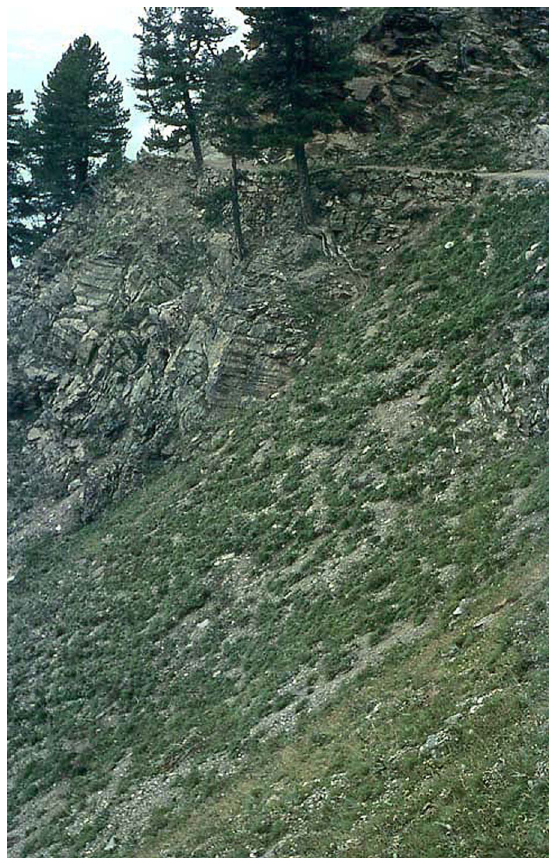
Fig. 14: Trampling effects in a sheltered site within the subalpine forest ( Larix decidua , Pinus cembra ) on the steep SW-facing slope above Pontresina village. Photo taken the author,